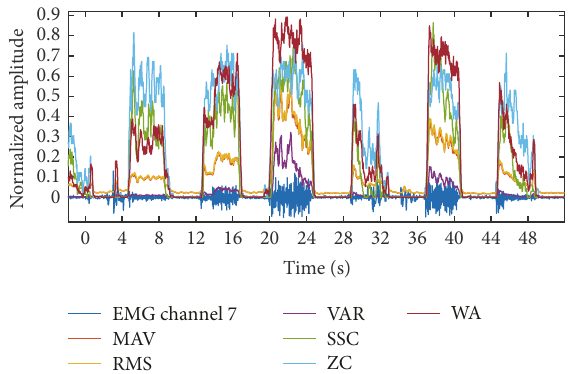
Figure 3: Example of the extracted features calculated from the EMG signal recorded on a single channel. The figure reveals that MAV and RMS features, in this case, almost overlap, but other fea- tures contain complementary information regarding EMG